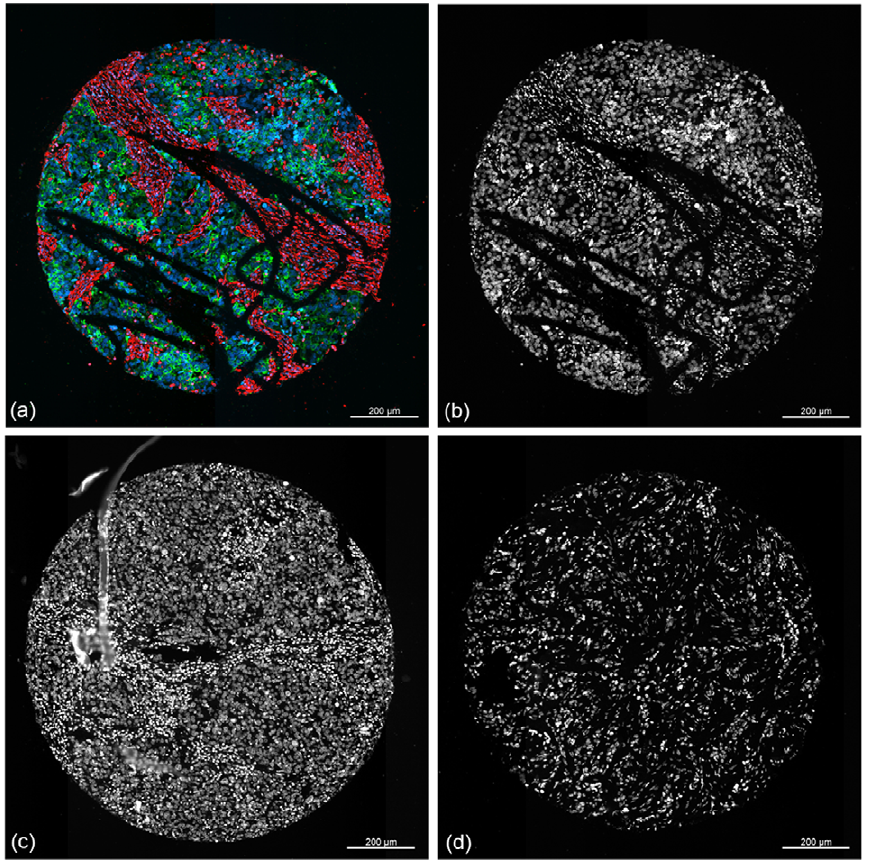
Figure 1. Microscopic image examples of different TMA-cores. ( a ) Representation of all 3 channel of a fluorescently stained core in RGB colorspace. Glyphs originated due to TMA’s preparation. Red representing the stromal marker (Vimentin), green the tumor marker (CK19) and blue the DAPI channel highlighting the cell nuclei; ( b ) the DAPI channel of ( a ) as an intensity image: in general tumor cells are darker and tighter connected than stromal cells; ( c ) another DAPI image of a core with a high density of cells; (d) an example of a core with a lower density of cells shows the high heterogeneity among the cores.